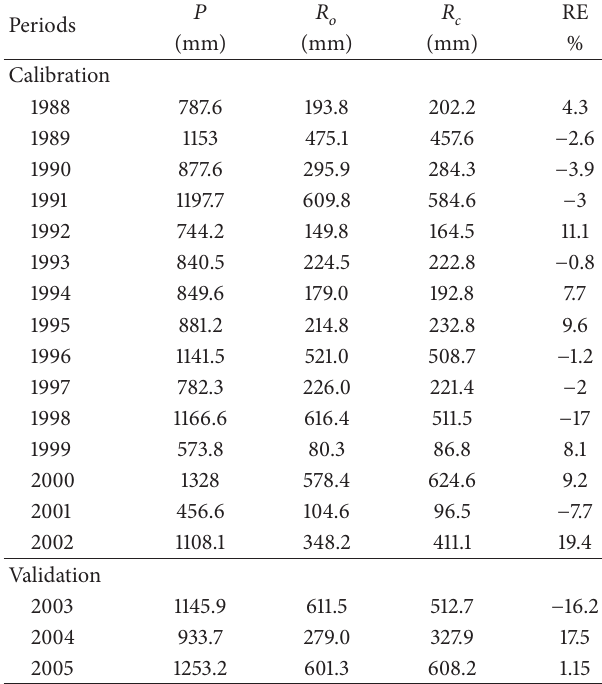
Table 2: Calibration and validation results of the daily XAJ model in the upper Huaihe River